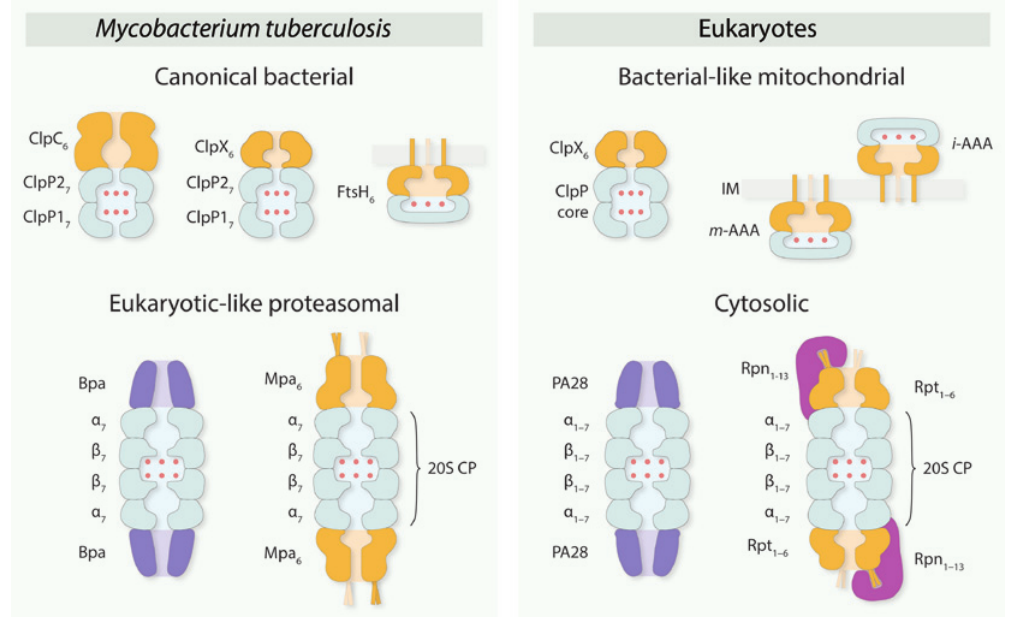
Figure 1: Compartmentalizing proteases of Mycobacterium tuberculosis and their eukaryotic counterparts. Compartmentalizing protease complexes comprise a core cylinder (light blue), enclosing the proteolytic active sites (red), that associates with energy-dependent (orange) or energy-independent (violet) regulatory ring-complexes to form the fully active protease. Mtb has the canonical bacterial degradation systems, -the cytosolic Clp proteases and the membrane-associated FtsH protease-, homologs of which can also be found in eukaryotic mitochondria. The main eukaryotic degradation machine is the 26S proteasome, built of the 20S core particle (20S CP) and the 19S regulatory particle ATPase (orange) and non-ATPase (pink) subunits. Unusual for the bacterial kingdom, Mtb harbors a proteasome complex in addition to the canonical bacterial degradation machines. This bacterial proteasome, found predominantly in the act- inobacterial phylum and a few members of nitrospirae and verrucomicrobae, is of simpler subunit composition than its eukaryotic